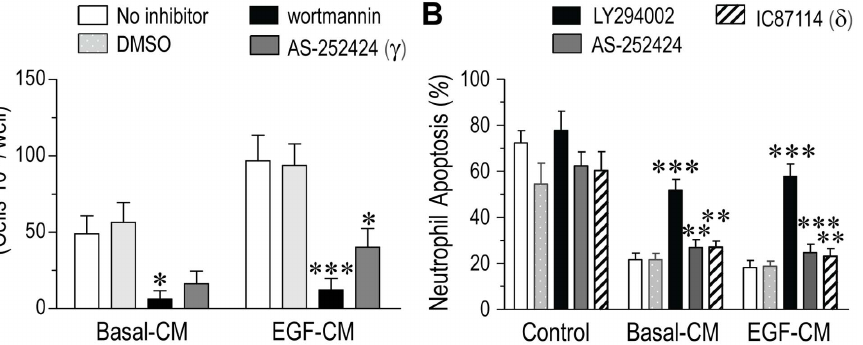
Figure 5. Activation of class I PI(3)Ks during neutrophil chemotaxis and survival induced by PBEC-CM from Mod/Sev asthmatics. (A) Pretreatment of neutrophils with wortmannin (100 nM, 30 min; solid bars ) inhibited both basal-CM and EGF-CM-induced migration compared with non-drug treated controls (p=0.011 and p=0.001, respectively), whilst the PI(3)K c -selective inhibitor, AS-252424 (30 m M, 30 min; darker shaded bars ) significantly blocked EGF-CM-mediated chemotaxis (p=0.021) ( n =8 donors). (B) Both basal-CM and EGF-CM–induced neutrophil apoptosis were markedly inhibited by LY294002 (30 m M; solid bars ), but the PI(3)K c (AS-252424, 30 m M) and d (IC87114, 10 m M; hatched bars )-selective inhibitors were partially effective ( n =9 donors). Data are mean 6 SEM and statistical significance by Mann-Whitney test, **p , 0.01 and ***p , 0.001 vs. non-drug treated neutrophils.